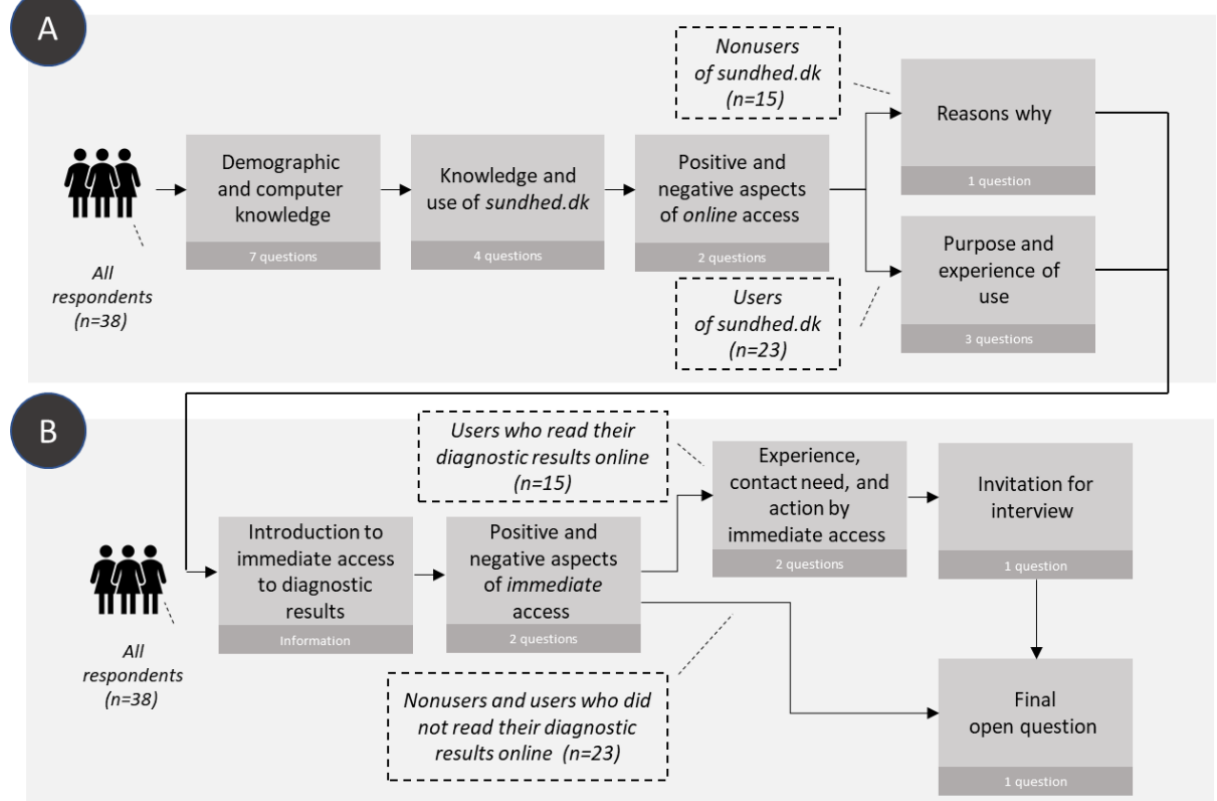
Figure 1. Overview of the online questionnaire, illustrating the interactive nature of the questionnaire and showing which respondent groups were given the different questions in each section. Section A primarily addressed attitudes toward and experiences with the patient-accessible electronic health records and section B addressed immediate access to scan results. All 38 respondents were asked about their attitudes toward online access and immediate online access regardless of previous use and